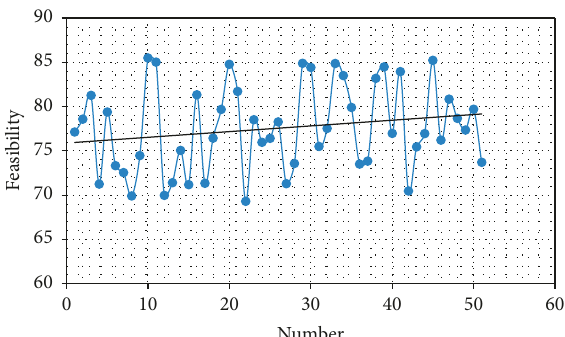
Figure 8: Statistical diagram of planning effect